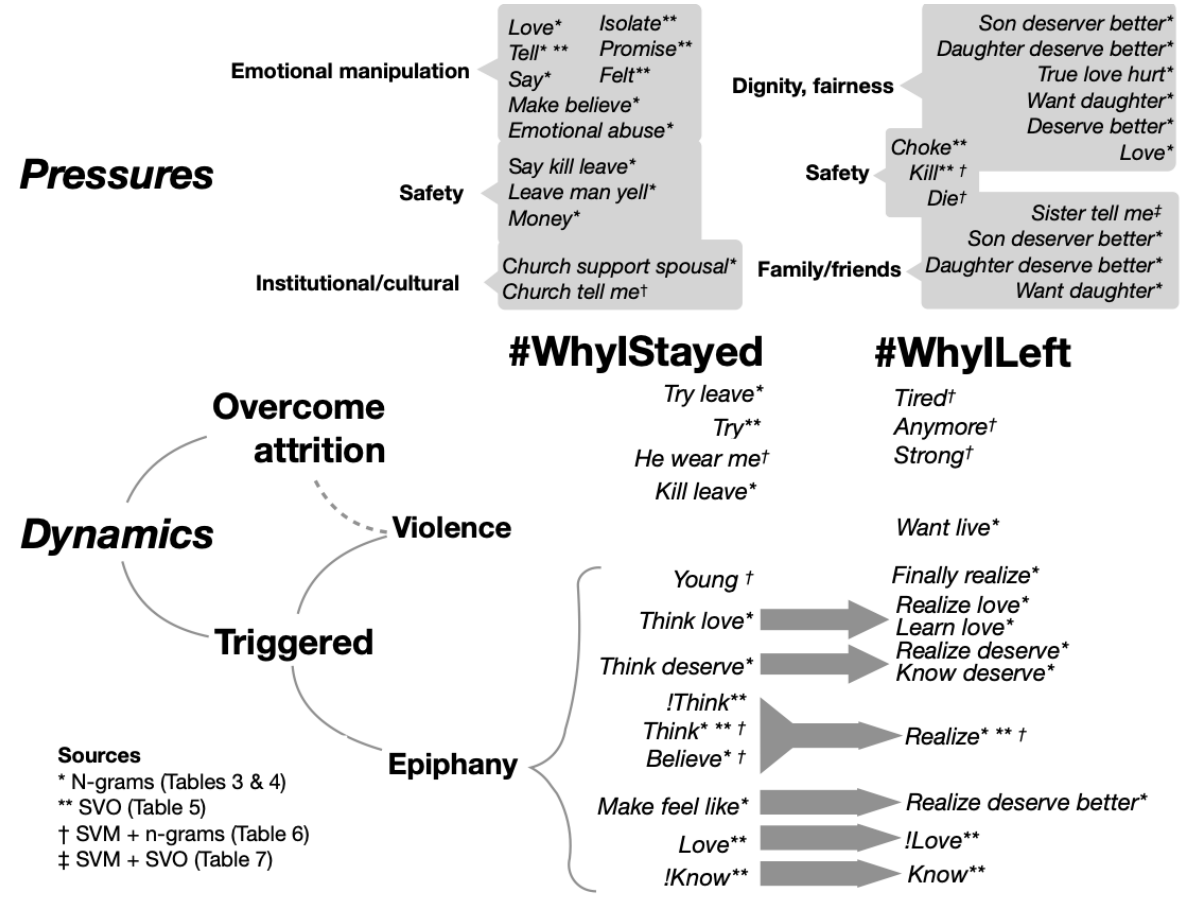
Figure 2. A pictorial summary of our results, grouped according to the forces that keep people in abusive relationships or cause them to leave and the dynamics involved in leaving. In the dynamics section, gray arrows denote pairs of textual features that represent opposing pressures and appeared on opposite lists in the same table (1-, 2-, or 3-gram, subject verb object, and support vector machine classification features). SVM: support vector machine; SVO: subject verb